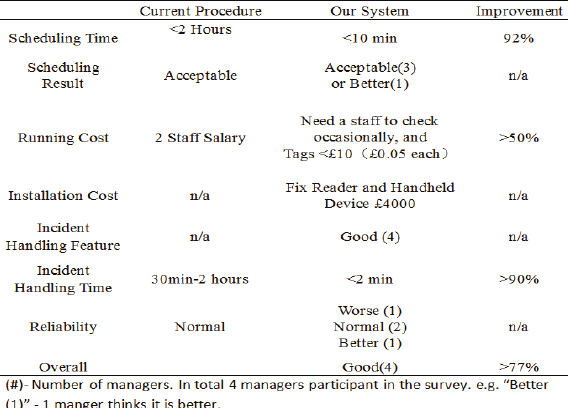
Table 5. Feedback Results from Managers